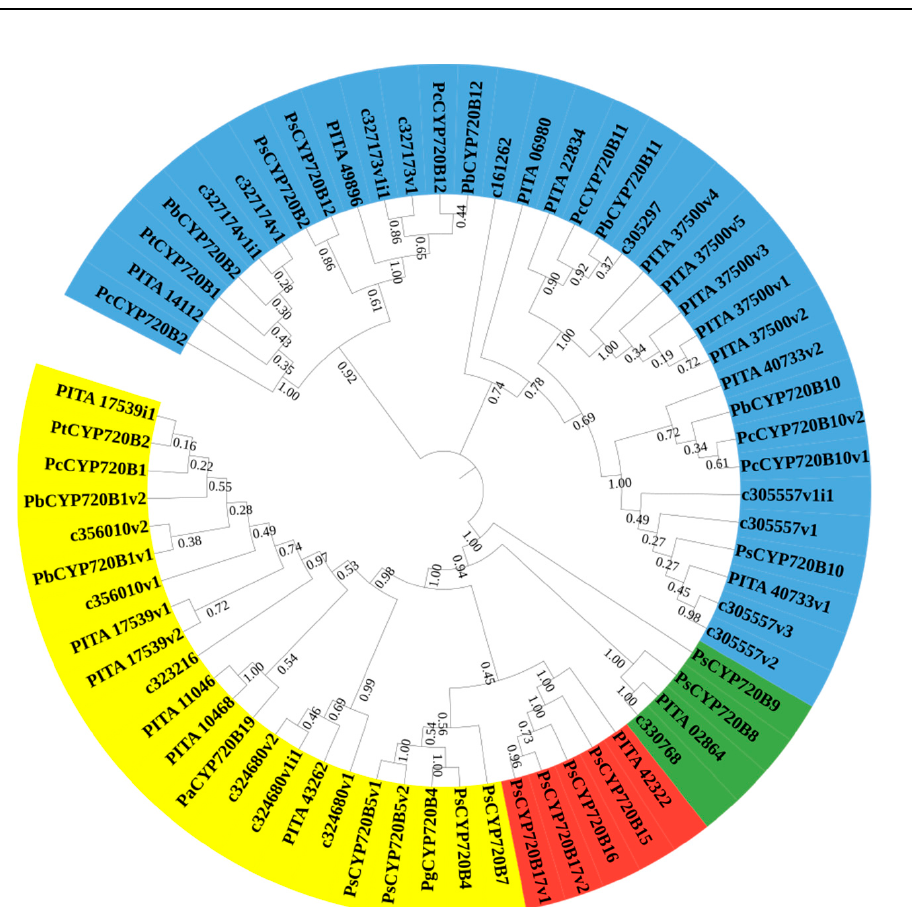
Figure 1. Phylogenetic relationships of the conifer-specific CYP720B genes. Note: v, putative allelic variant; i, insertion and deletion of fragments. The numbers in the figure represent the bootstraps value and the bootstraps value range from 0 to 1. The genes with blue backgrounds belong to clade I, green backgrounds belong to clade IV, red backgrounds belong to clade II, and yellow backgrounds belong to clade III. Table 2. The amino acid sequence of the conserved regions of CYP720B.